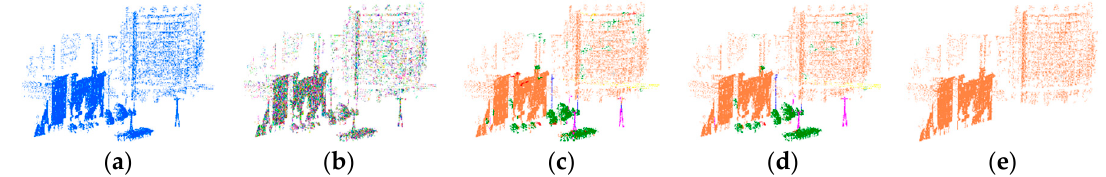
Figure 10. The illustration of building extraction of the purposed method. ( a ) Raw data; ( b ) super-points of non-ground points; ( c ) the initial results of semantic segmentation; ( d ) the final results of semantic segmentation; ( e ) the results of building extraction.